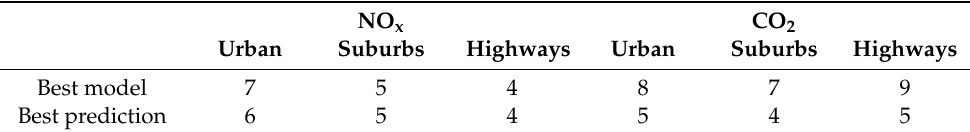
Table 13. Input number of features for best model and best prediction.